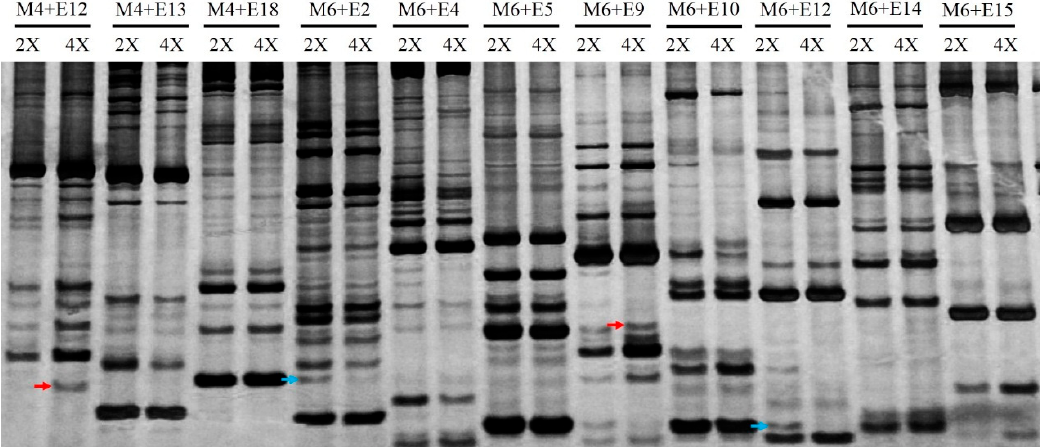
Figure 2. DNA-SRAP profiling of diploid and tetraploid of C. lavandulifolium : Upper panel represents primer combinations. 2X indicates diploid, and 4X indicates tetraploid. “ → ” to red arrows represents novel bands and blue arrows represent lost bands in the tetraploid. E# represents the em# primer, M# indicates me# primers. Bands detected range from 100 to 500 bp.